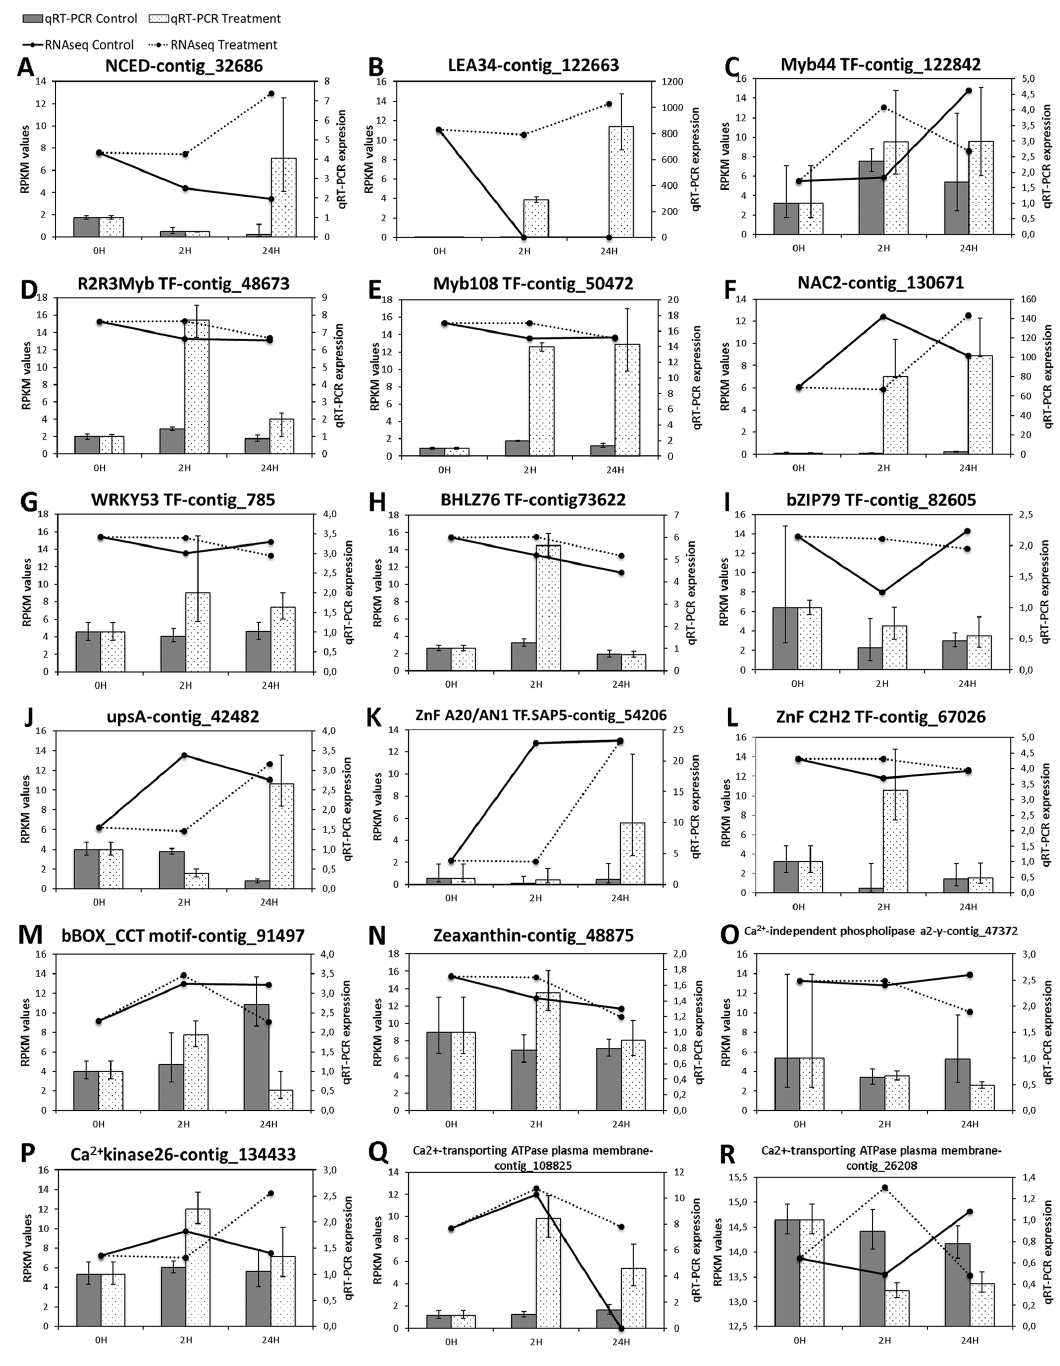
Fig 4. qRT-PCR validation of select genes in control and treated plants. The grey-scale bars represent relative gene expression in control (dark grey) and treated plants (light grey) by qRT-PCR analysis (right y-axis). qRT-PCR data show the average relative expression of two biological samples with three technical replicates each one. Lines represent RPKM values of the transcripts in control (black line) and treated plants (dotted line) by RNAseq (right y-axis). The error bars represent the standard error between replicates in qRT-PCR